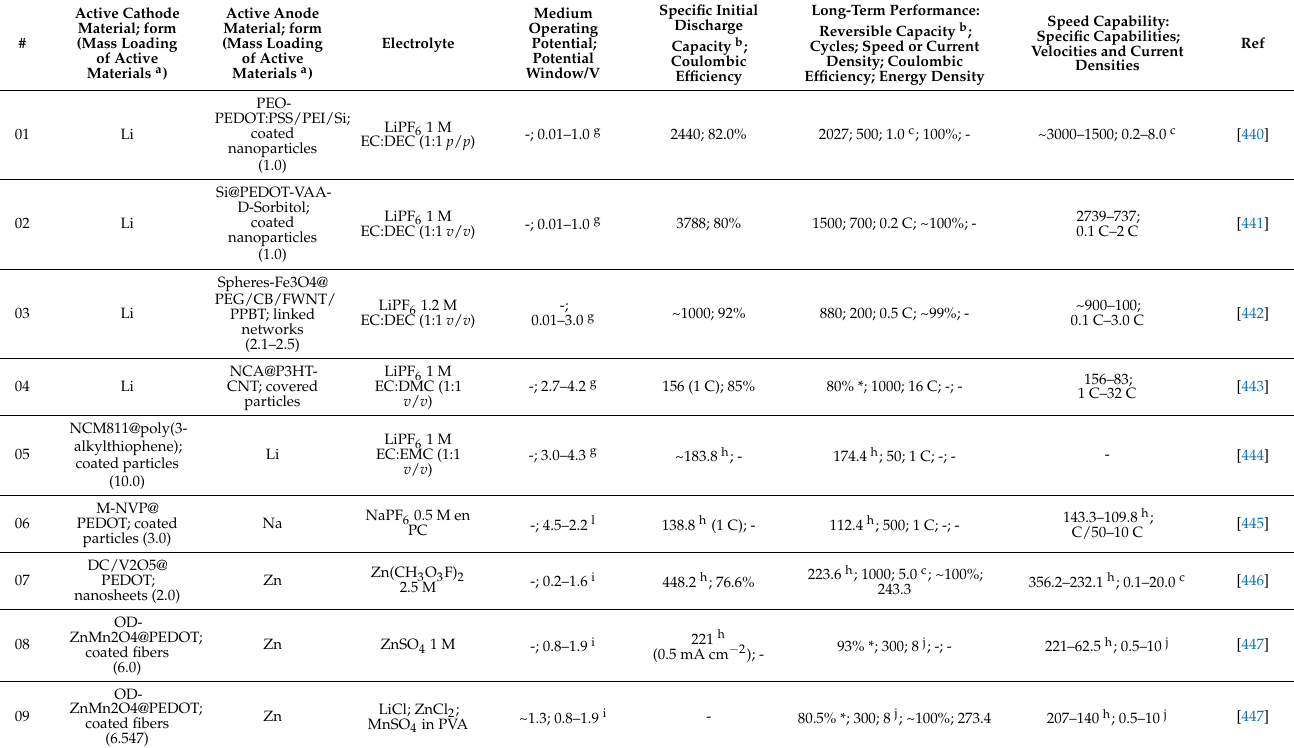
Table 8. PEDOT and other nanostructured PTh derivatives in various configurations were evaluated for rechargeable battery electrodes, with their performance